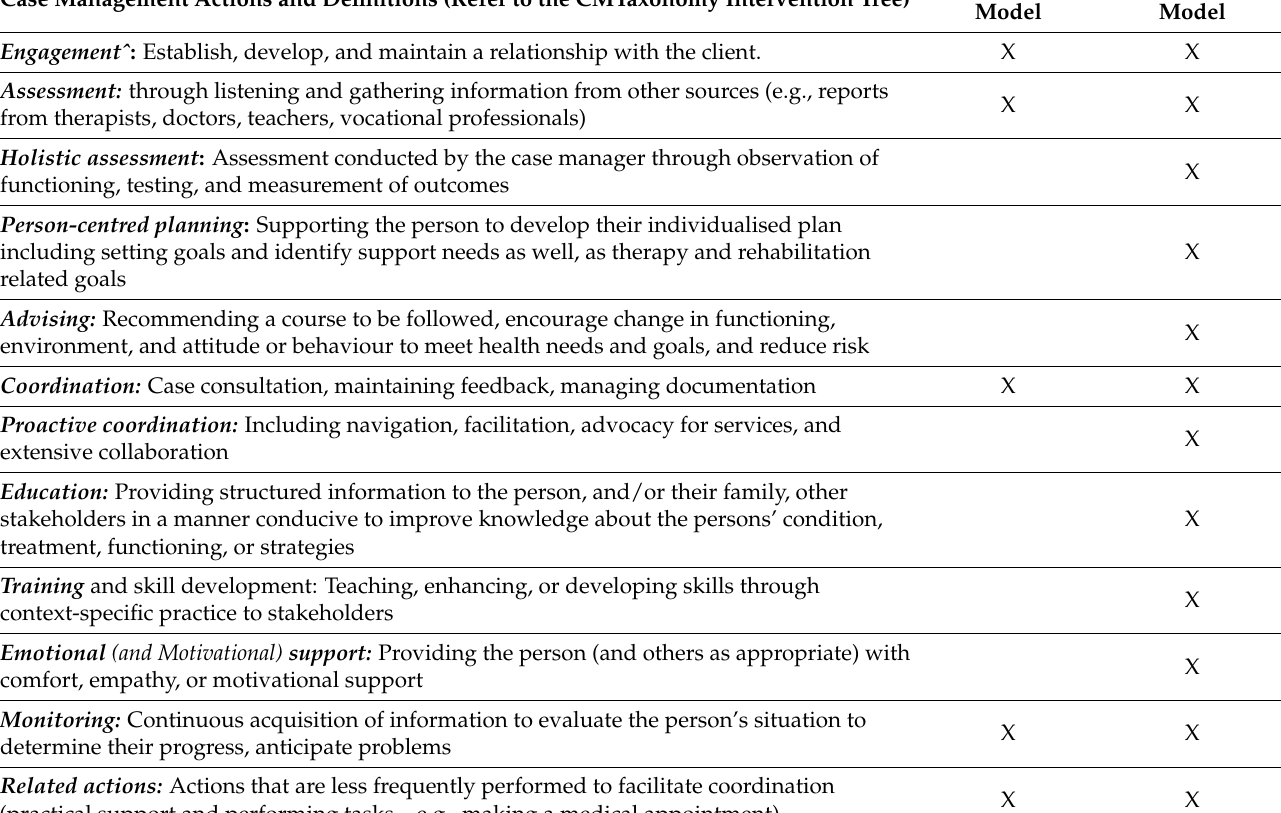
Table 1. The model of case management mapped to the case management taxonomy actions (mecha- nisms)